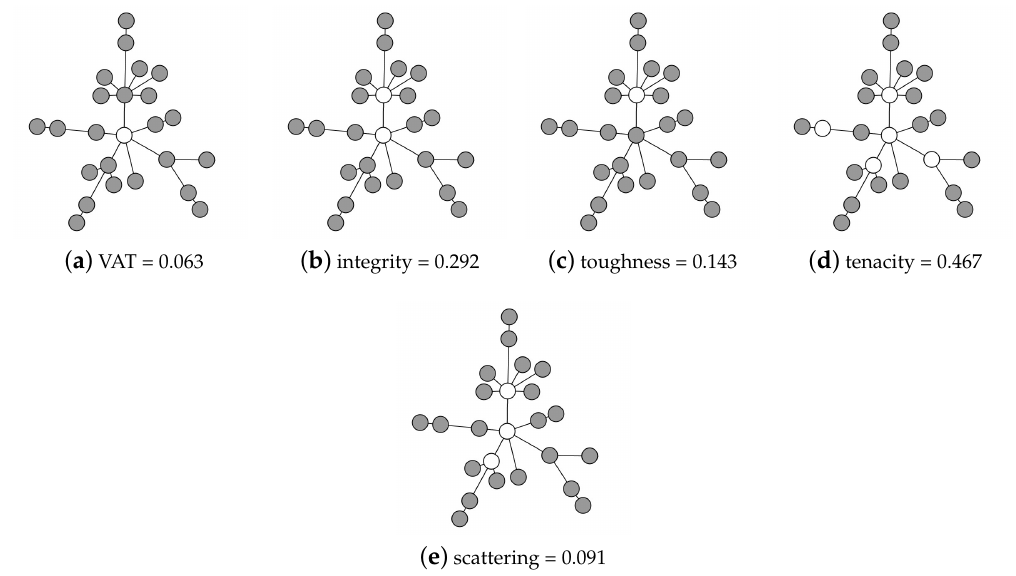
Figure 1. Attack sets returned by the resilience measures used in this